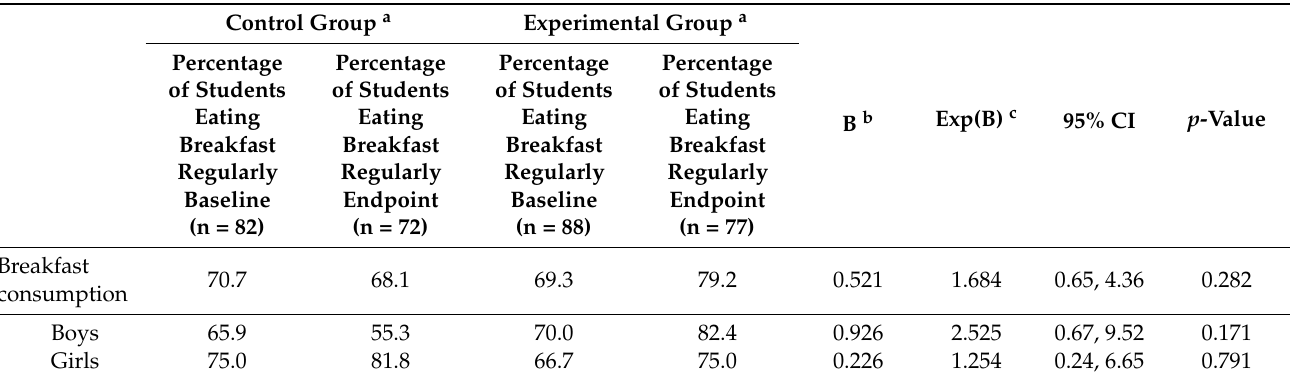
Table 3. Differences in the odds of eating breakfast at least five times per week between the experi- mental and control